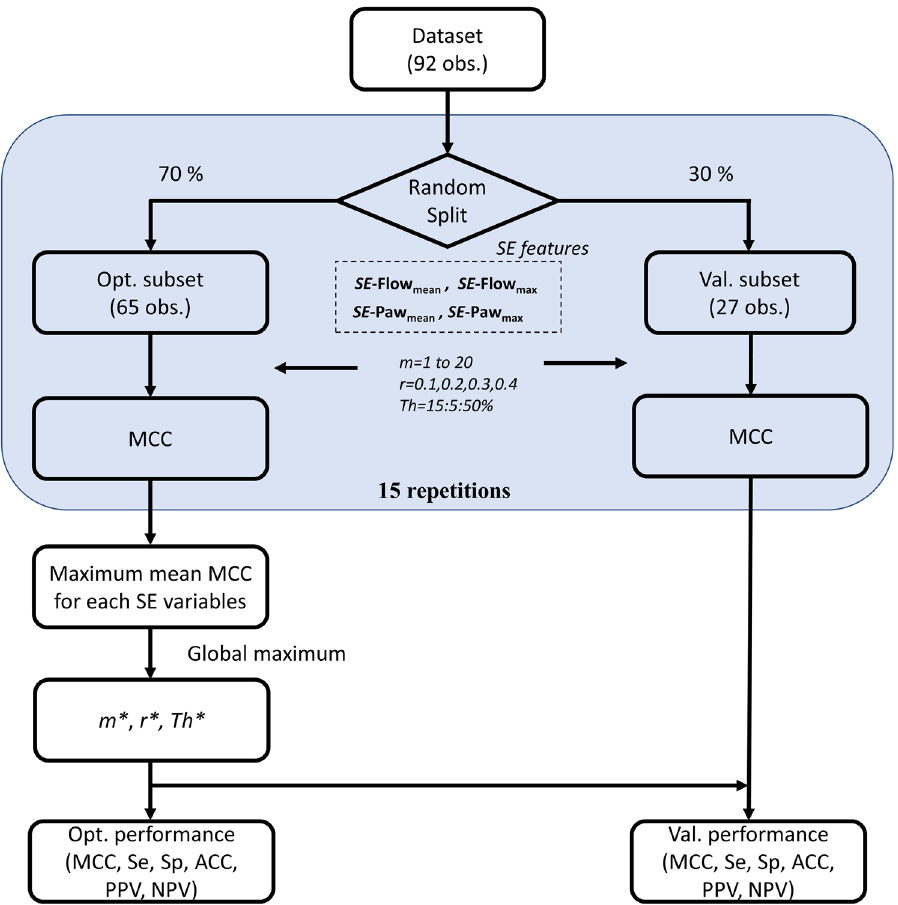
Figure 3. Flowchart for the optimization procedure and validation. Procedure to select the optimal sample entropy ( SE ) settings ( m and r ) and the threshold of change ( Th ) for each SE airway flow (Flow) and airway pressure (Paw) features ( SE -Flow mean , SE -Flow max , SE -Paw mean , and SE -Paw max ). The dataset visually validated by the experts was randomly divided into two subsets: optimization (Opt.) and validation (Val.). The optimization procedure was repeated a total of 15 times using different subsets (randomly selected each time). The global maximum mean value of the Matthews correlation coefficient (MCC) determined the optimal values of m* , r* , and Th* among all possible combinations and all SE -derived features. Finally, the mean values of the measures of accuracy were computed for the optimal combination of parameters in both the optimization and the validation